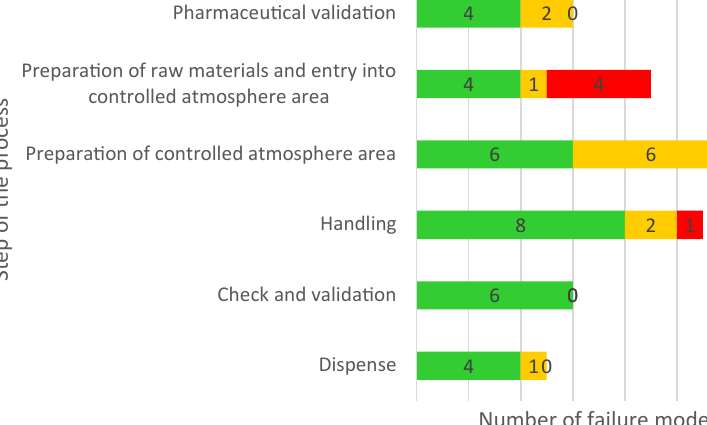
Figure 1: Failure modes by step and their criticalities.